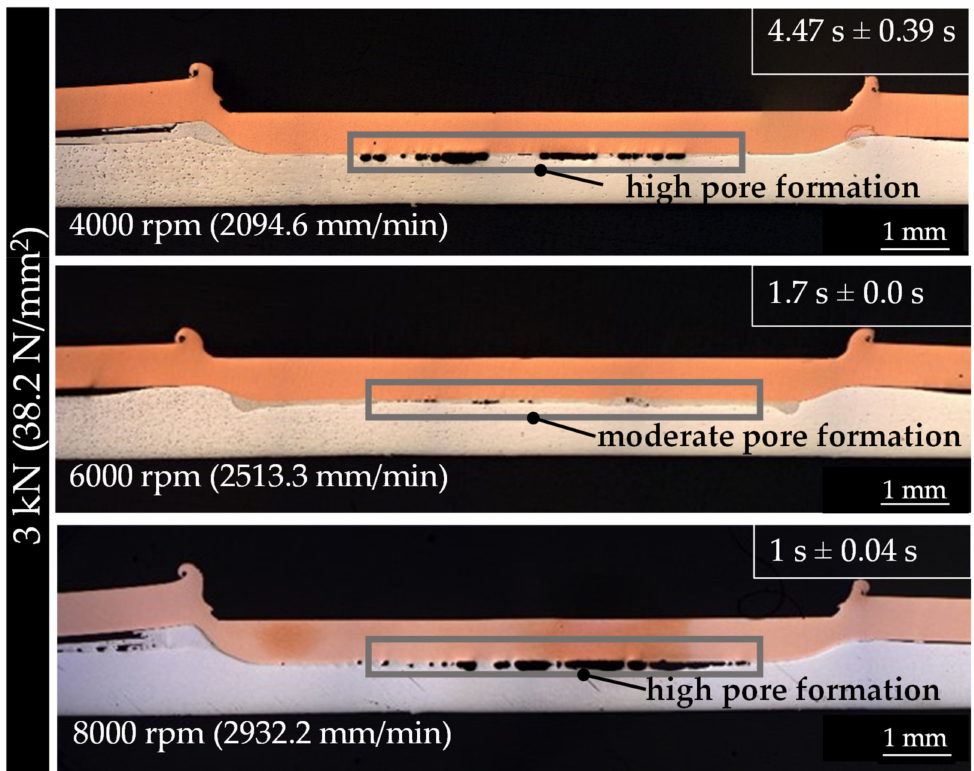
Figure 10. Metallographic micrographs of welds at constant process force and different rotational speeds. High pore formation at both lower and higher rotational speeds. Relatively lower pore formation at moderate rotational speeds—used tool (Ø10 mm).